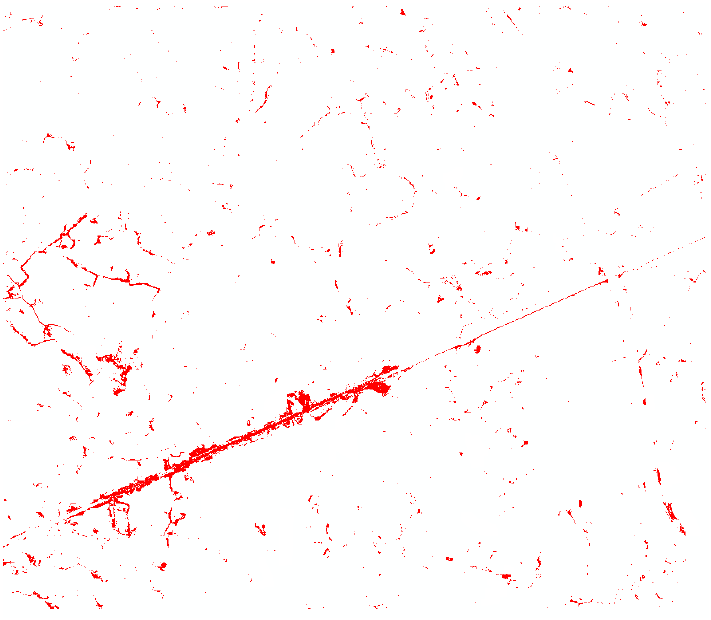
Figure 16. Road extraction result of the pixel-based classification method.